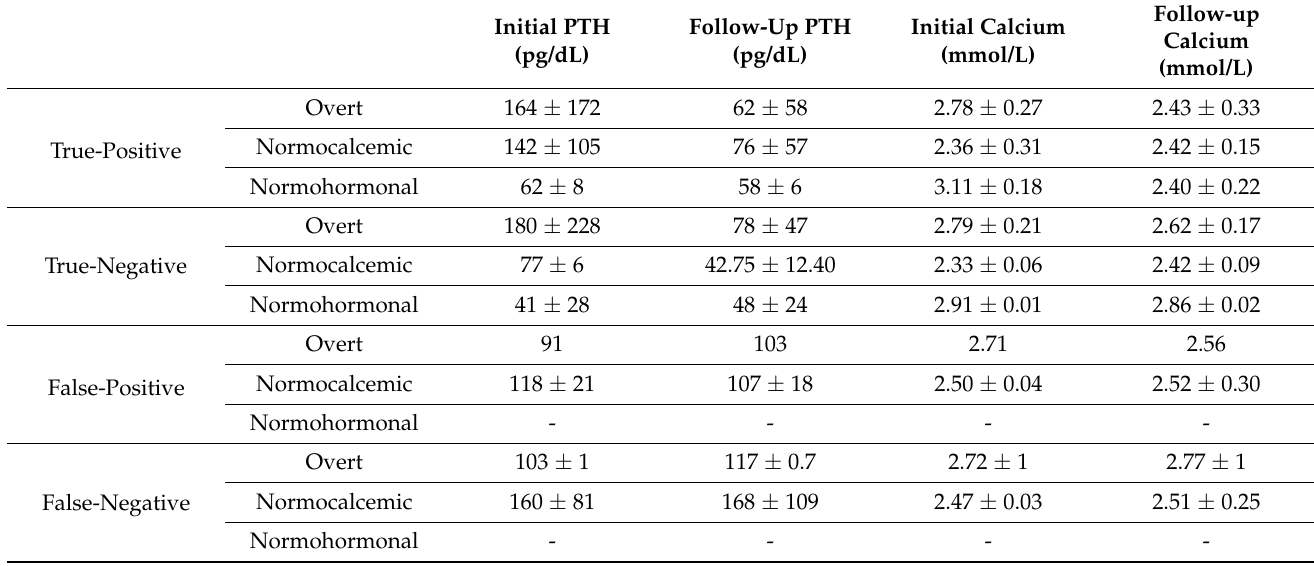
Table 2. Detailed laboratory results of the included